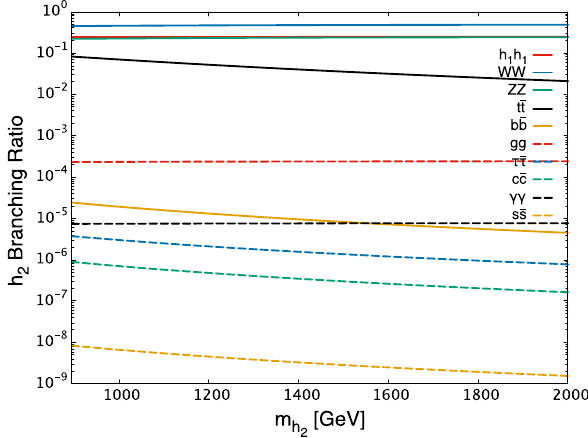
Fig. 5 Branchings of the heavy scalar h 2 into various SM particles. The h 1 h 1 , WW and ZZ are the dominant decay modes. The decay rates remain constant essentially or decrease with m h